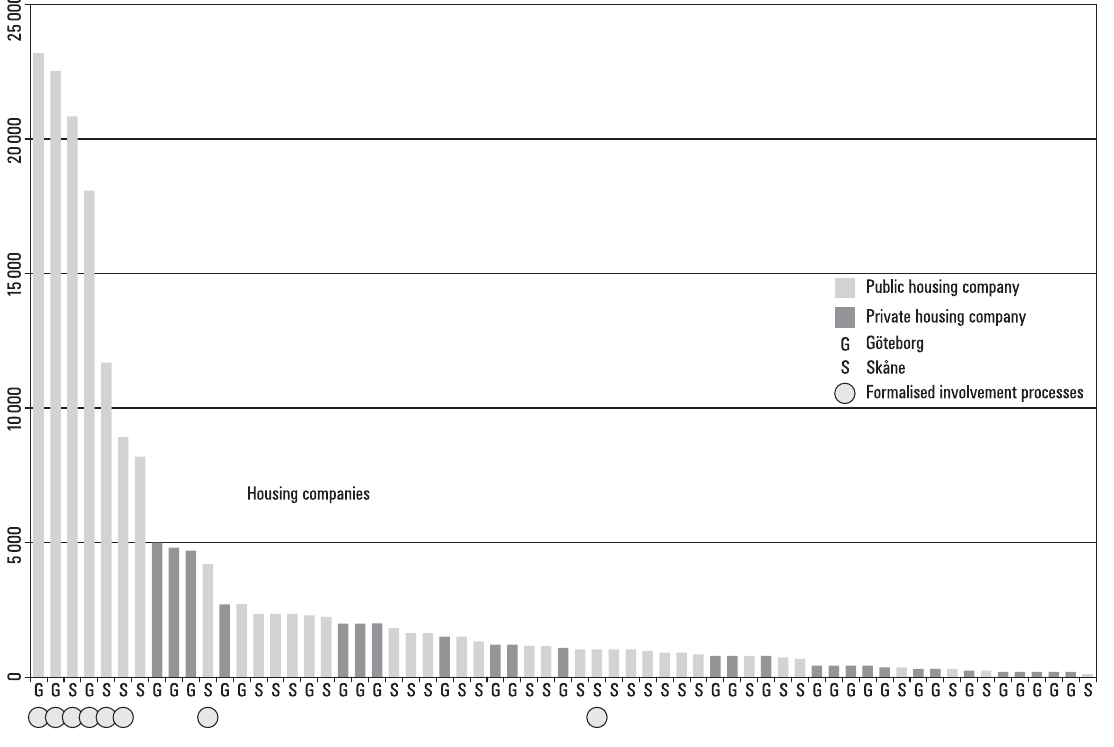
Figure 2 . Housing companies in the survey, each represented by a bar in the diagram, the length indicating the number of apartments owned. Colours indicate if publicly or privately owned, letters G and S at the bottom indicate which region, and dots indicate if there are examples of formalised involvement processes within the